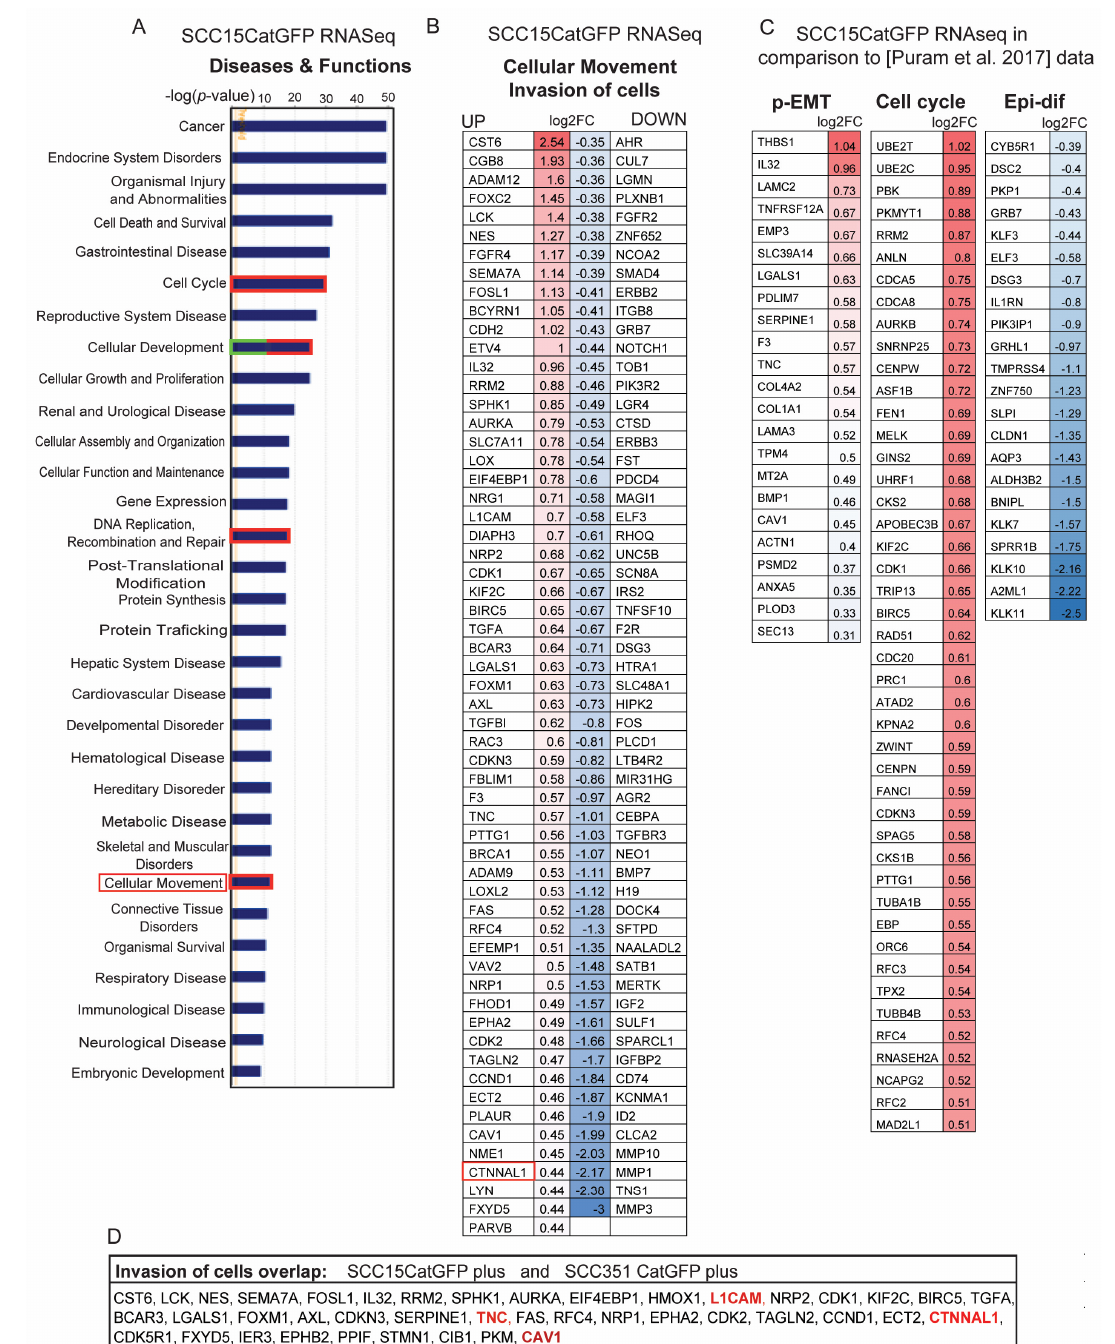
Figure 4. Signature genes of invasive Catulin-GFP reporter-labeled cancer cells. ( A ) Bar chart presenting the most changed processes in the sorted SCC15CatGFP plus population. ( B ) Heatmap of genes changed in the sorted SCC15CatGFP plus population associated with the invasion of cells. ( C ) Heatmaps of genes changed in the sorted SCC15CatGFP plus population associated with the cell cycle, partial epithelial–mesenchymal transition (p-EMT), and epithelial differentiation (Epi-dif) in comparison to genes presented by [Puram et al., 2017] [30]. Catenin alpha-like 1 (CNTTAL1) gene is boxed. ( D ) Table presenting upregulated genes common for the SCC15CatGFP plus and SCC351CatGFP plus populations involved in the in invasion of cells. CTNNAL1 and other genes of interest are highlighted in